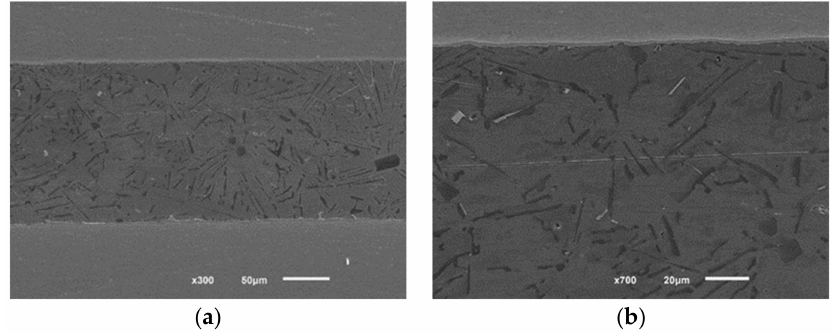
Figure 15. ( a ) SEM images (SEI) of brazed joint using Al-13Si filler alloy at 585 ◦ C (13/585) close to the middle of the joint; ( b ) The interface at the active part of the parent